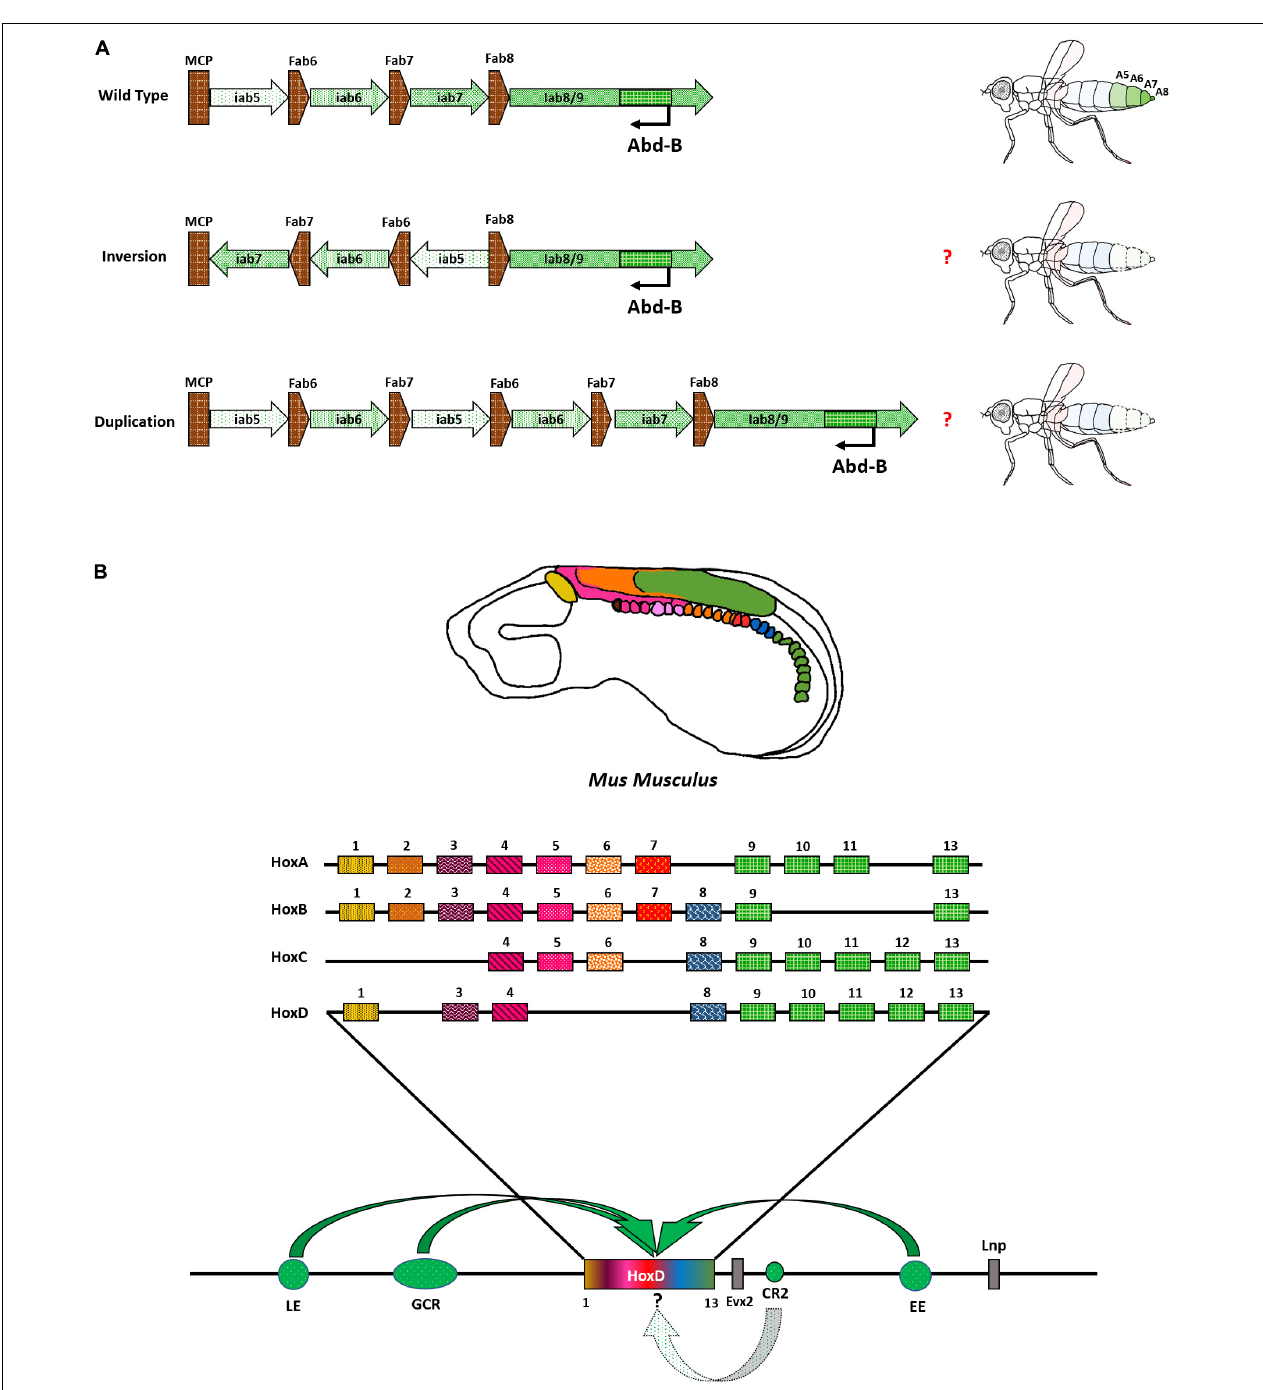
FIGURE 5 | Re-arrangement of Abd-B locus and vertebrate Hox complex with CRMs. (A) Representation of proposed experiment to re-arrange the CRMs of Abd-B locus in the BX-C. (B) Hox genes are expressed as indicated in Mus musculus. HoxD locus is shown as a representation of regulatory modules associated with Hox complexes. Bold, curved arrows indicate their approximate presence and interaction with Hox complex (not to scale and point pre cis ely on a particular Hox). The role of CR2 in modulating Hox is still unknown and is represented by a dotted arrow.